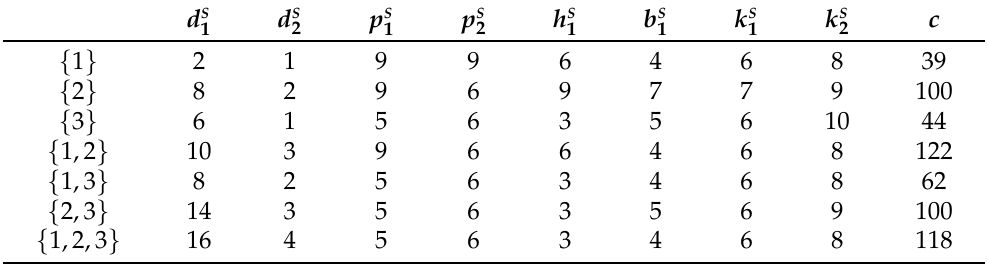
Table 2. SI-situation with two periods and three players and the associated